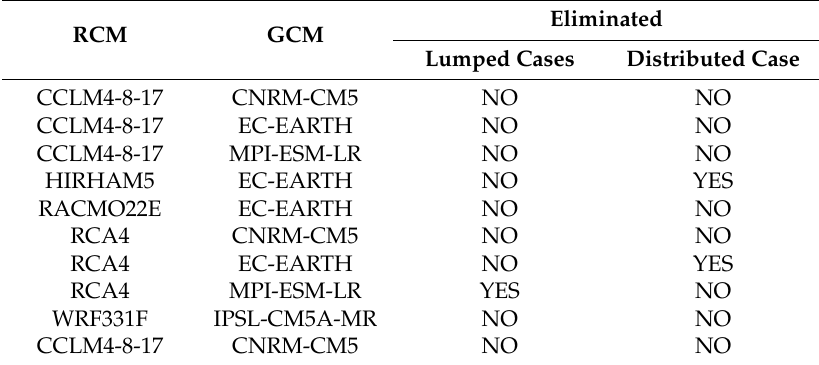
Table 3. Eliminated and uneliminated models in the multi-objective analysis of the delta change approaches for the lumped and distributed cases.